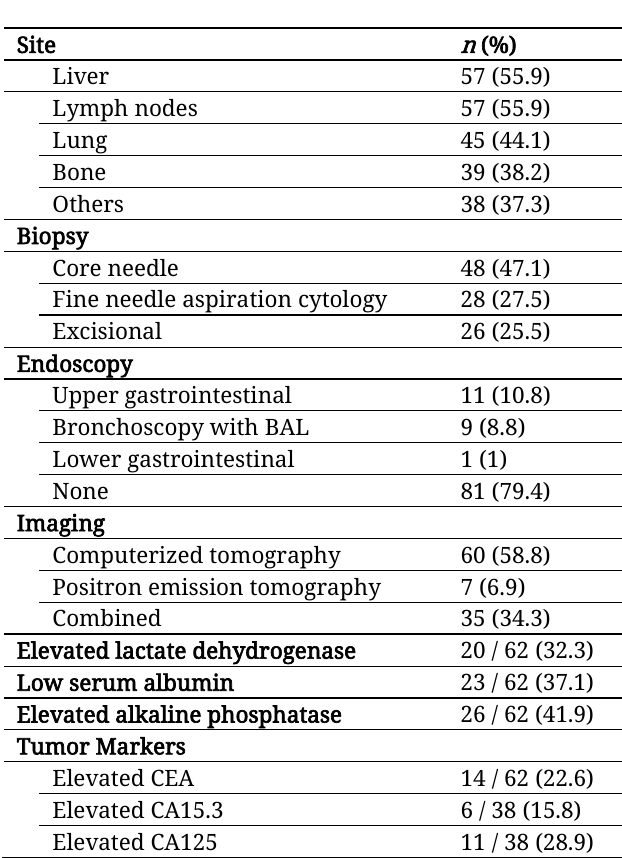
Table 1: Characteristics of 102 patients with